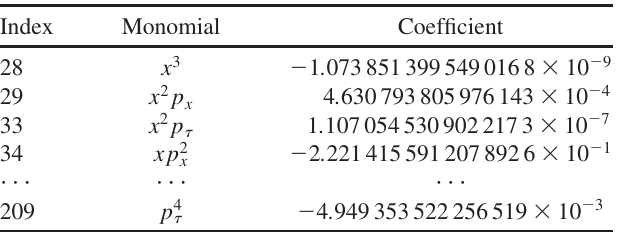
TABLE III. First few nonvanishing Lie generators f ILC damping ring wiggler.